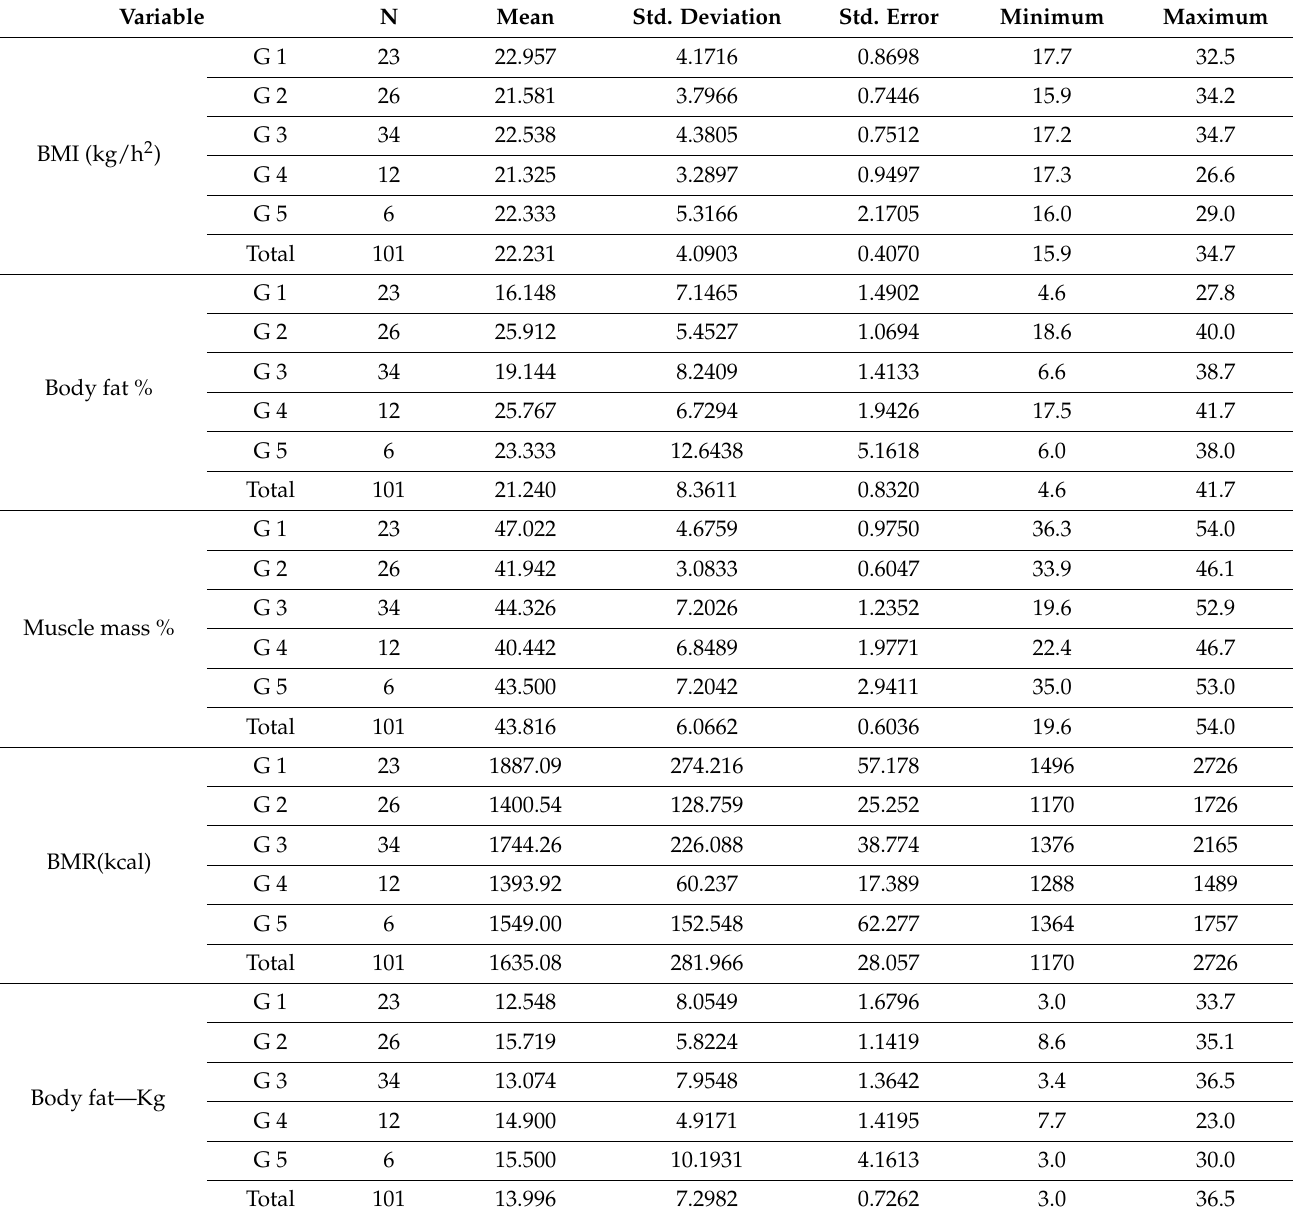
Table 3. Synthetic table with morphological